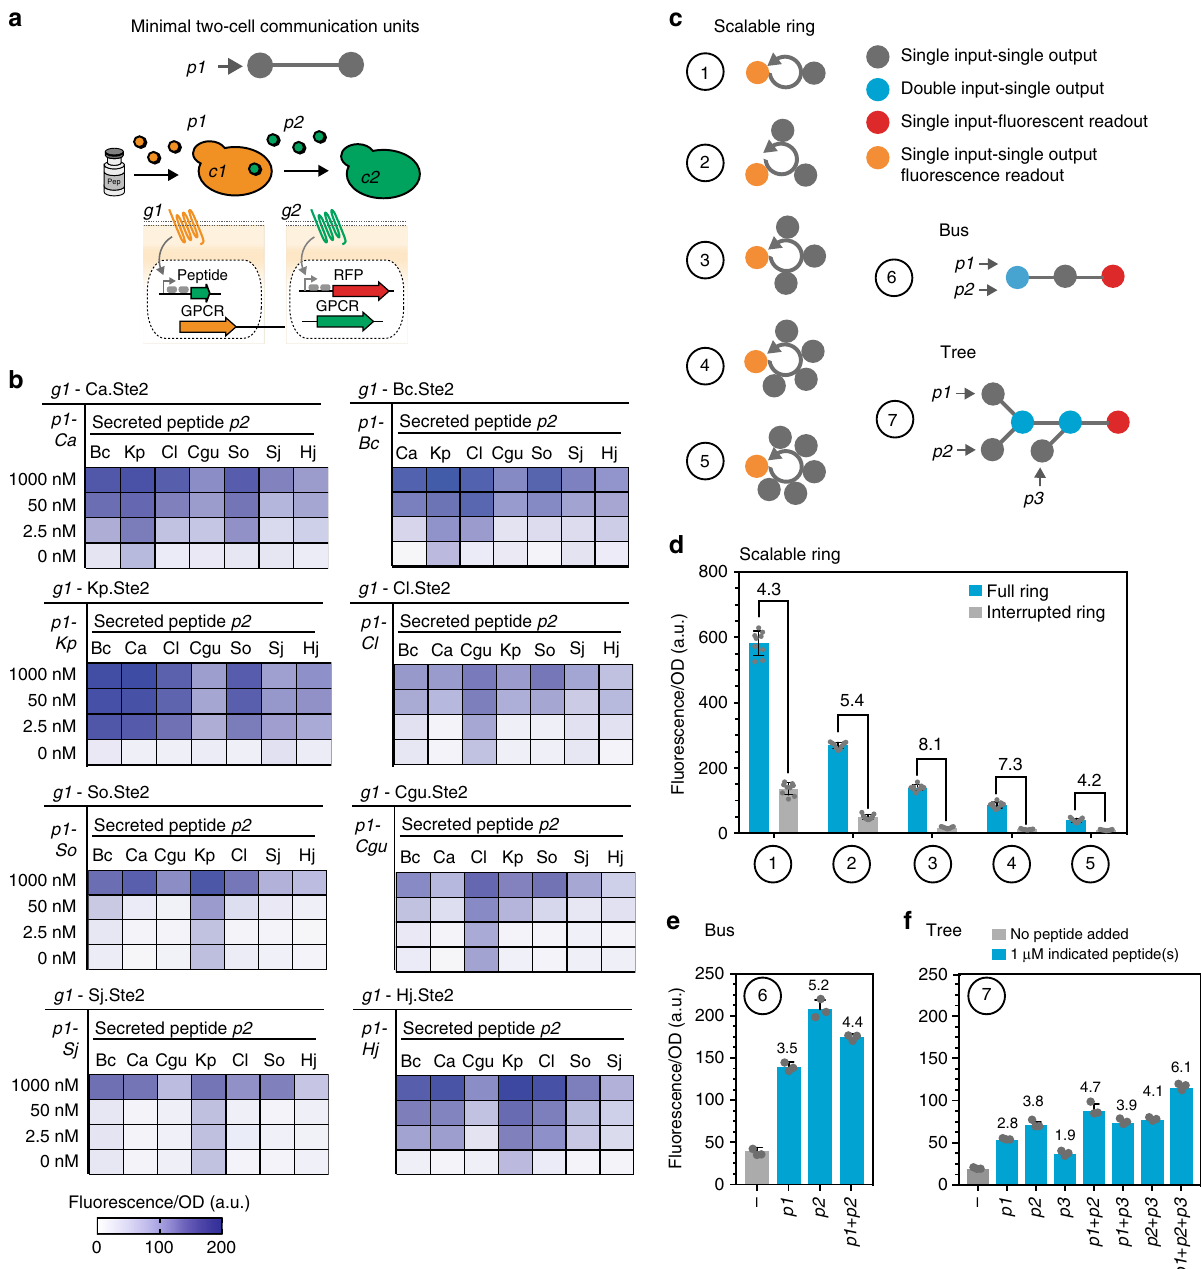
Fig. 3 Synthetic microbial communication: Two-cell communication links yield various communication topologies. a Illustration of minimal two-cell links. Cell 1 ( c1 ) senses synthetic peptide through GPCR 1 ( g1 ). Activation of g1 leads to secretion of peptide 2 ( p2 ). p2 is sensed by cell 2 ( c2 ) through GPCR 2 ( g2 ). g2 activation is coupled to a fl uorescent read-out. Signal transmission from c1 to c2 is assessed by recording transfer-functions using co-cultures of c1 and c2 and increasing amounts of p1. b Functional information transfer through all 56 links established from eight peptide-GPCR pairs. Eight GPCRs at the g1 position were coupled to secretion of the seven non-cognate peptides at the p2 position. Heatmaps show the fl uorescence/OD 600 value of c2 after exposing c1 to increasing doses of p1 . Supplementary Figures 16 and 17 list full data sets and references heat maps. c Overview of the implemented communication topologies. Gray nodes: cells are able to process one input (expressing one GPCR) giving one output (secreting one peptide). Blue nodes: cells are able to process two inputs (OR gates, expressing two GPCRs) giving one output (secreting one peptide). Orange nodes: cells constitutively secrete the peptide for the next clockwise neighbor, and report on ring closure via a fl uorescent read-out upon receiving a peptide signal from the counter- clockwise neighbor. Red nodes: cells are able to receive a signal and respond via a fl uorescent read-out. d Ring topologies with an increasing number of members were established. An interrupted ring, with one member dropped out, was used as the control. Measurements were performed in triplicate, and error bars represent standard deviations. The fold-change in fl uorescence between the full-ring and the interrupted ring is indicated for each topology. e, f A three-yeast bus topology ( e ) and a six-yeast branched tree-topology ( f ) were implemented (panel c ). Fluorescence was measured after induction with all possible combinations of the three input peptides (zero, one, two, or three peptides). The numbers above the bars indicate the fold-change in fl uorescence over the no-peptide induction value. Measurements were performed in triplicate, error bars represent